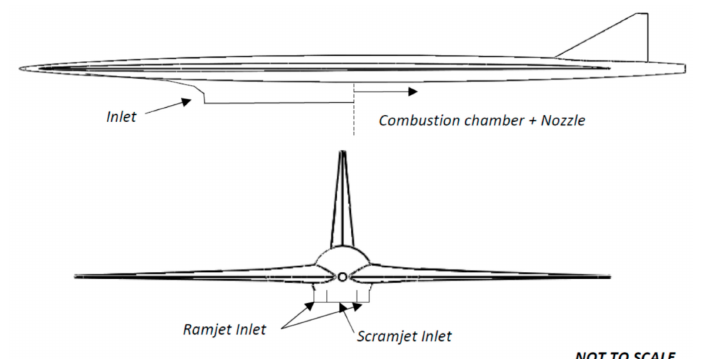
Figure 23. Side and front view of the hypersonic vehicle.